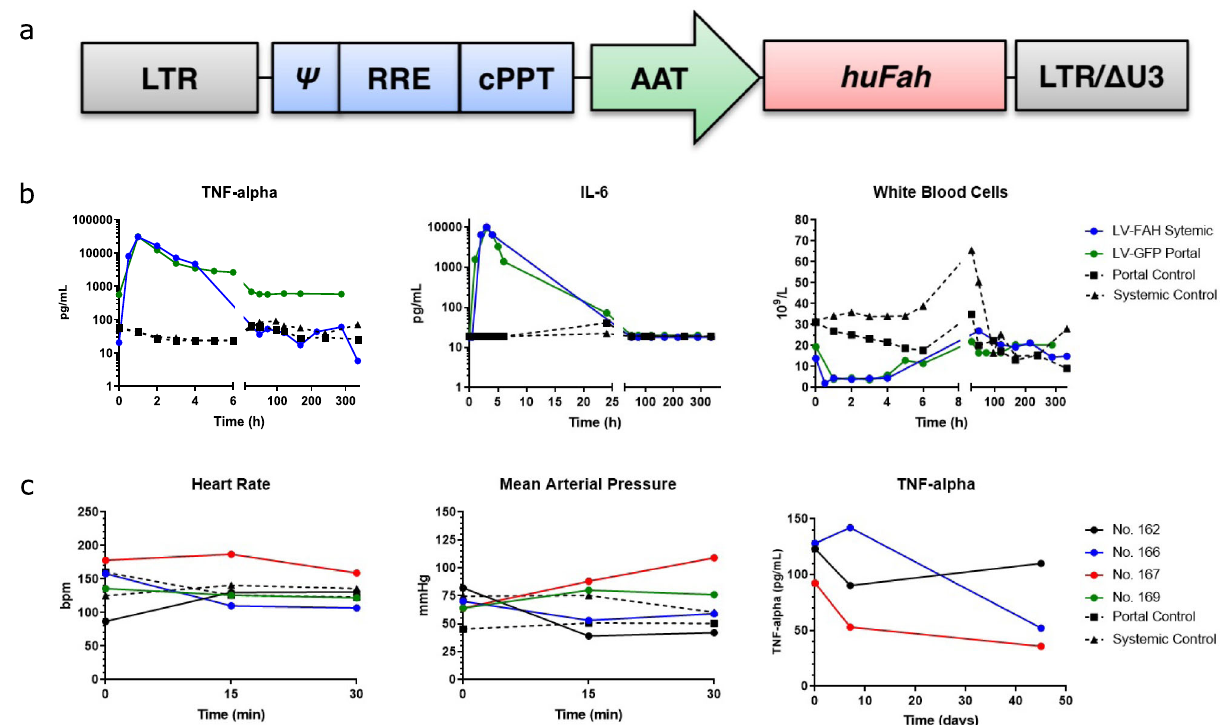
Fig.1|LV-FAHadministrationtopigs.a Schematicrepresentationofthelentiviral vector carrying the human FAH cDNA under control of the human alpha-1- antitrypsin (AAT) promoter. LTR long terminal repeat, Ψ psi packaging sequence, RRE Rev-responsive element, cPPT central polypurine tract; LTR/ Δ U3, 3 ′ long terminal repeat with deletion in U3 region. b Acute in fl ammatory response after systemic LV-FAH administration compared to reference portal vein LV-GFP deliv- ery. No signi fi cant differences in TNF-alpha or IL-6 concentrations or white blood